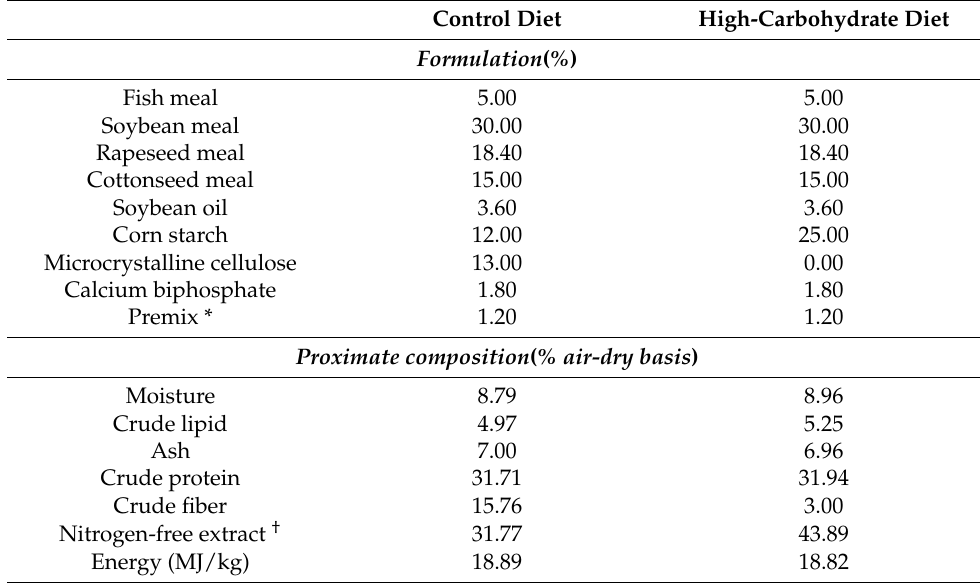
Table 1. Formulation and proximate composition of the experimental